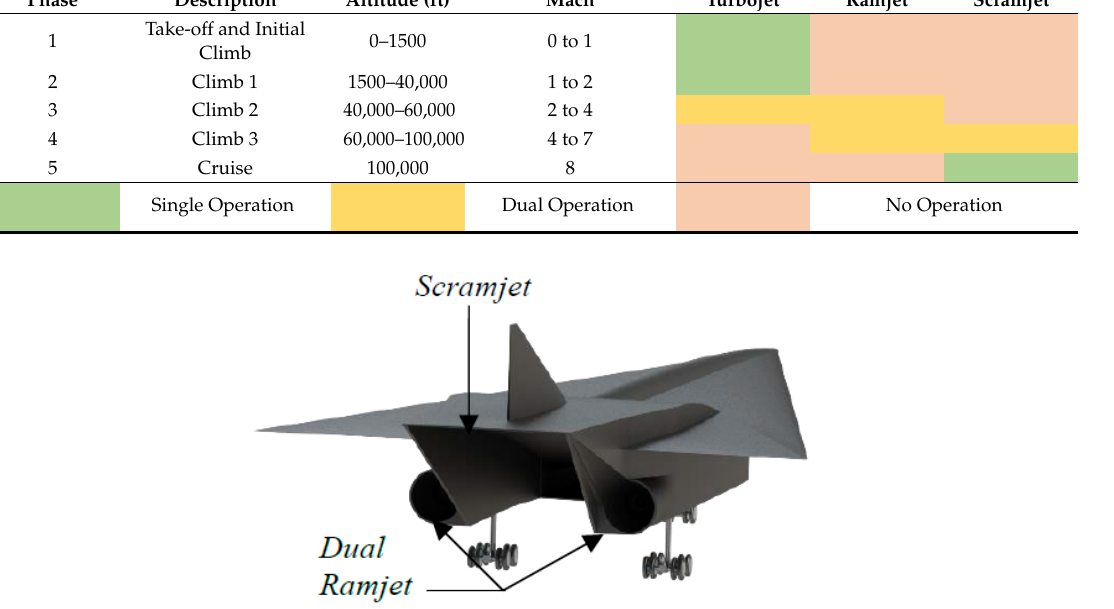
Table 1. Concept aircraft target flight profile.